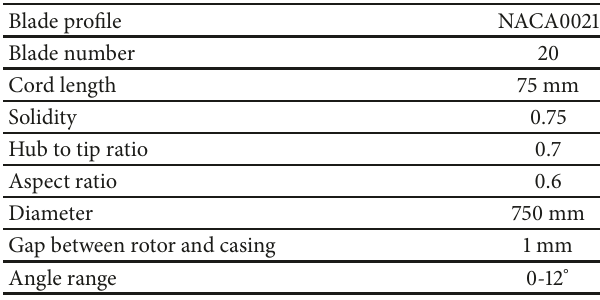
Table 1: Parameters of the pitch-controlled Wells